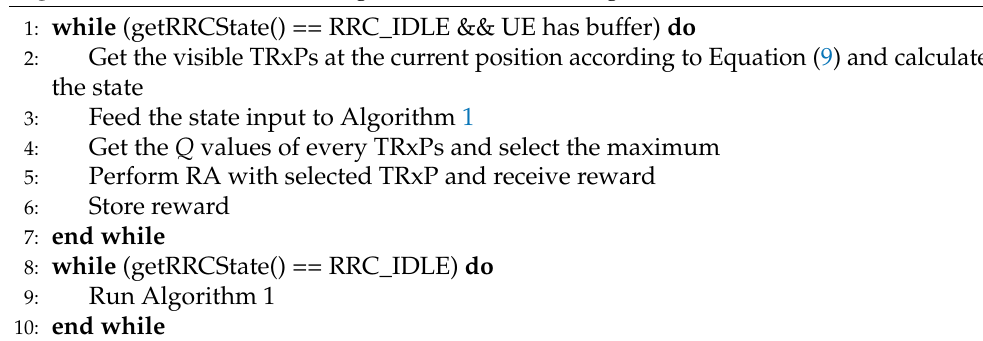
Algorithm 2 DQN-based Intelligent TRxPs Selector Algorithm: